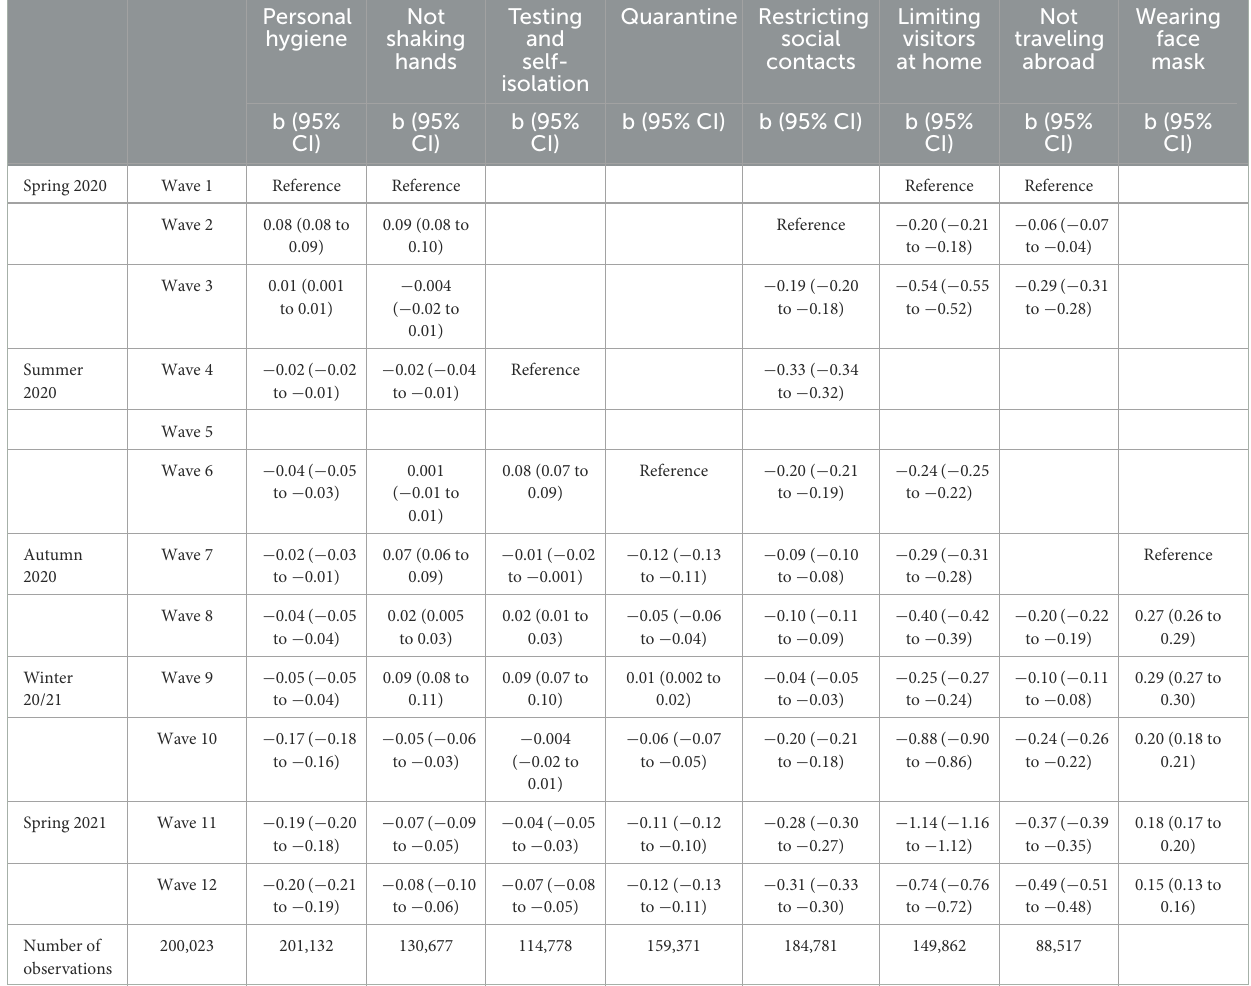
TABLE 3 Multivariable analysis of trends in support of COVID-19 mitigation measures over